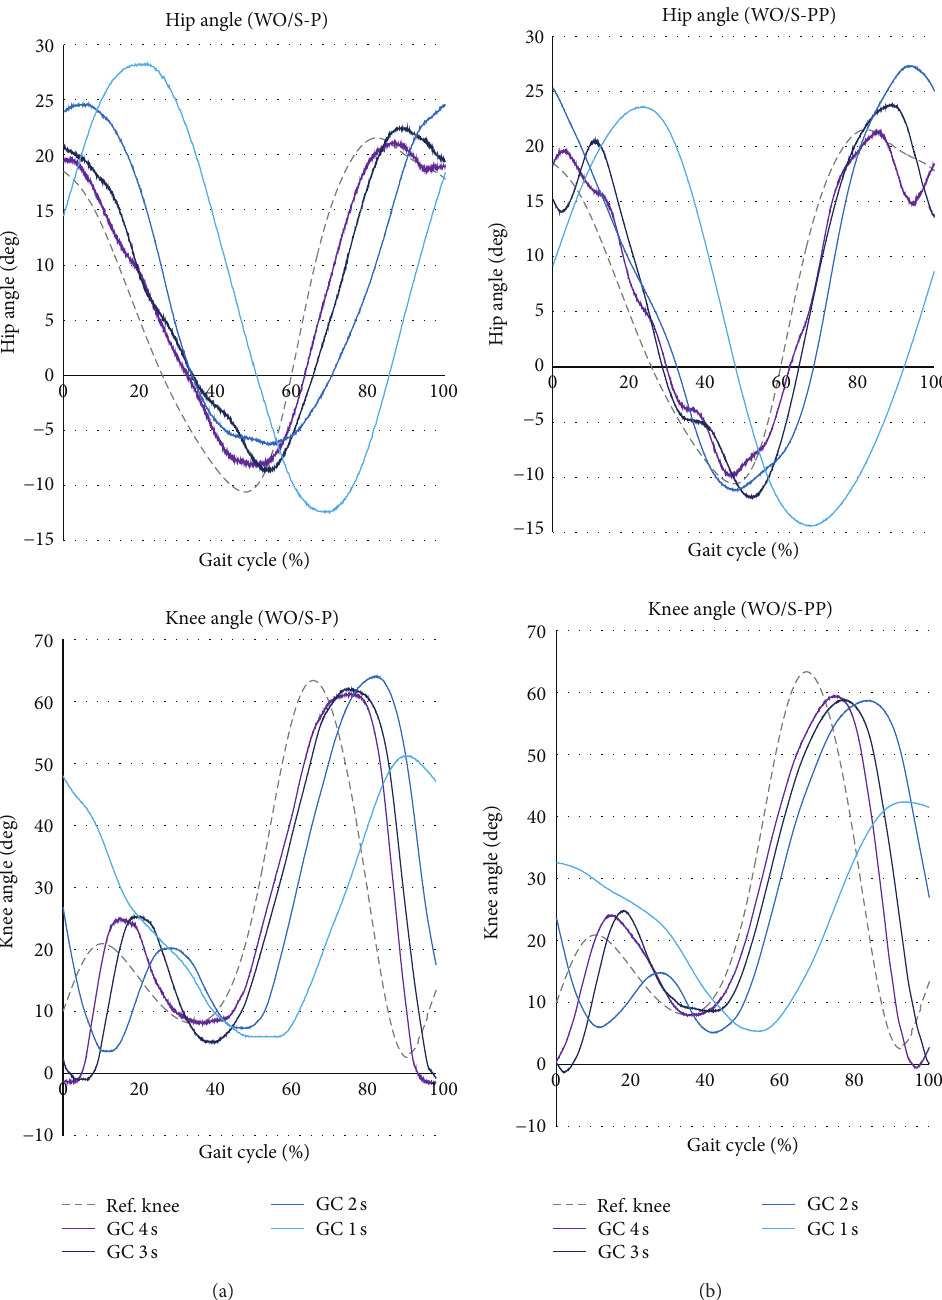
Figure 11: Hip and knee joints’ trajectory evaluation of the leg orthosis controls between two designed controller schemes (i.e., P controller and PP controller) tested